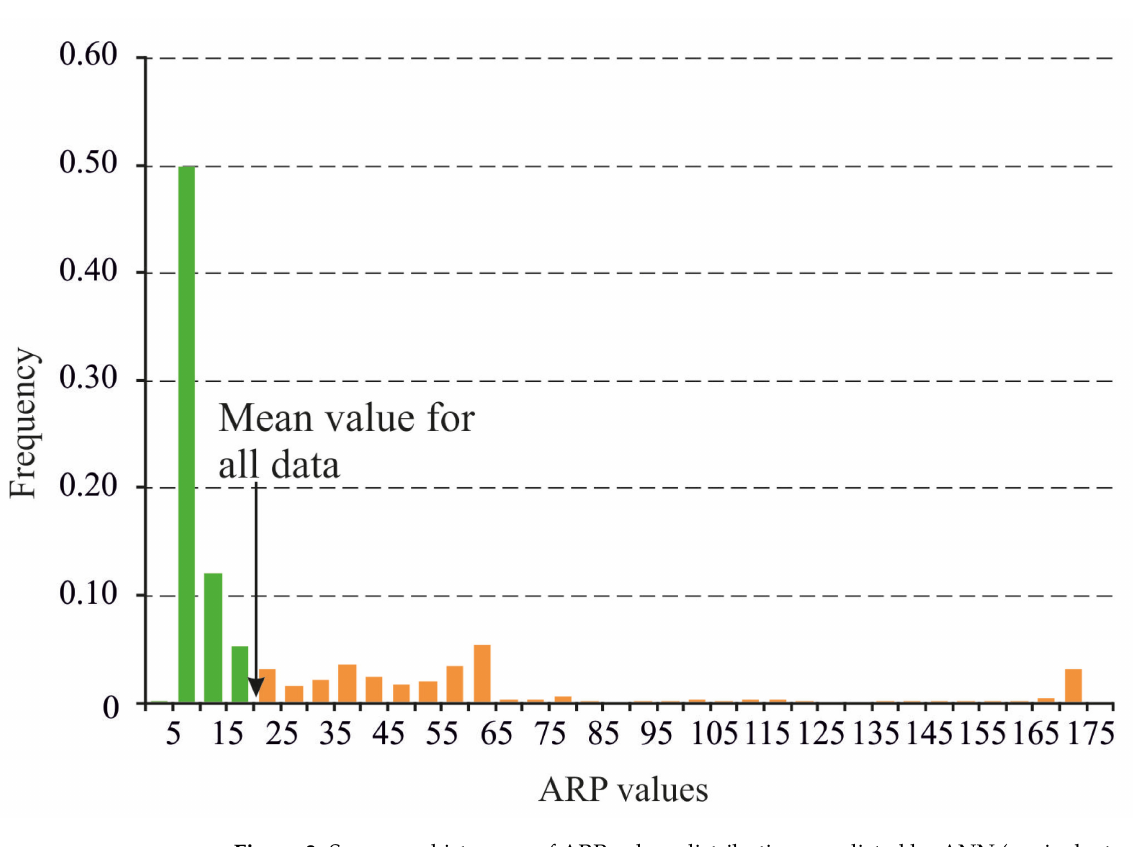
Figure 3. Summary histogram of ARP values distributions predicted by ANN (equivalents per gram of dry weight of products). The ARP value less than the mean is highlighted in green, and the values above the average are highlighted in orange in the figure.